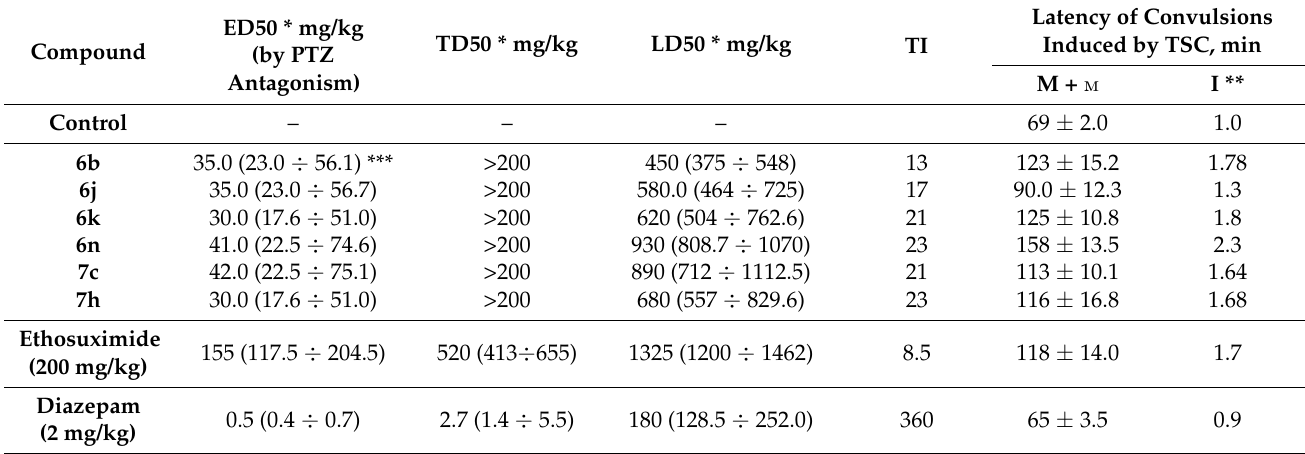
Table 3. Anticonvulsant activity and toxicity of the examined compounds 6b , j , k , n and 7c , h